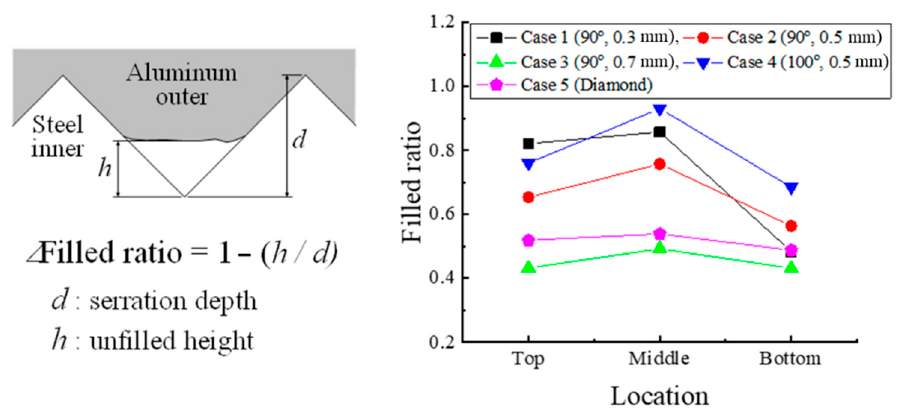
Table 6. Maximum torque (Kn-mm). Figure 16. Filled ratio. Figure 16. Filled